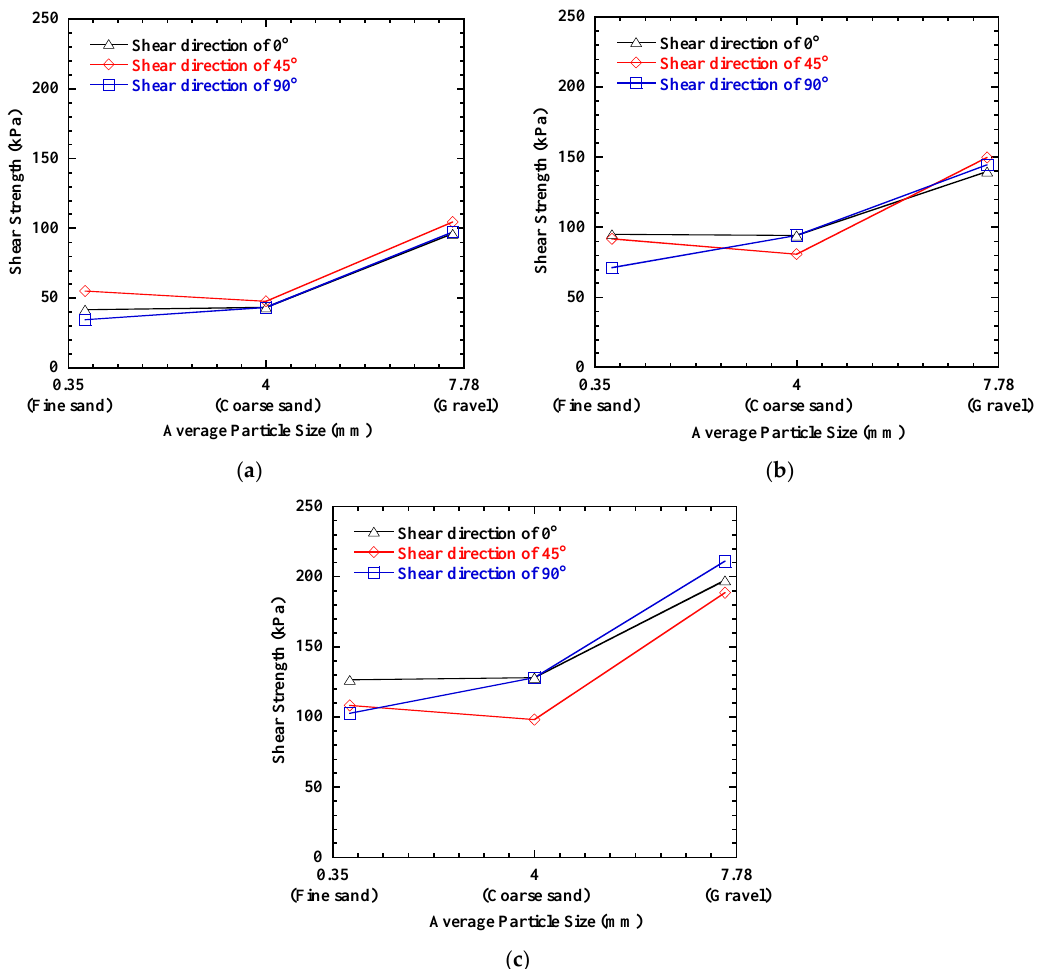
Figure 15. The influence of particle size on the shear strength of soil–biaxial geogrid (SS40) interfaces. ( a ) Normal stress of 50 kPa, ( b ) normal stress of 100 kPa, ( c ) mormal stress of 150 kPa. Table 3. Percentages of shear strength variation (%) for fine sand–biaxial geogrid, coarse sand–bi- axial geogrid and gravel–biaxial geogrid interfaces. Particle